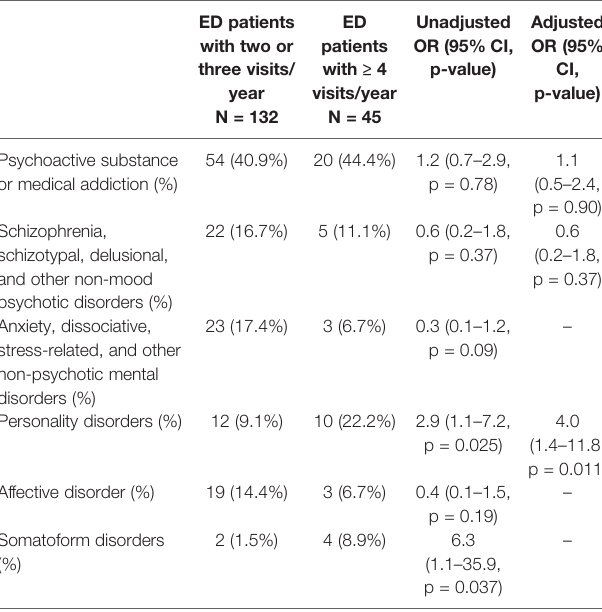
TABLE 4 | Leading diagnoses of mental disorders encountered.